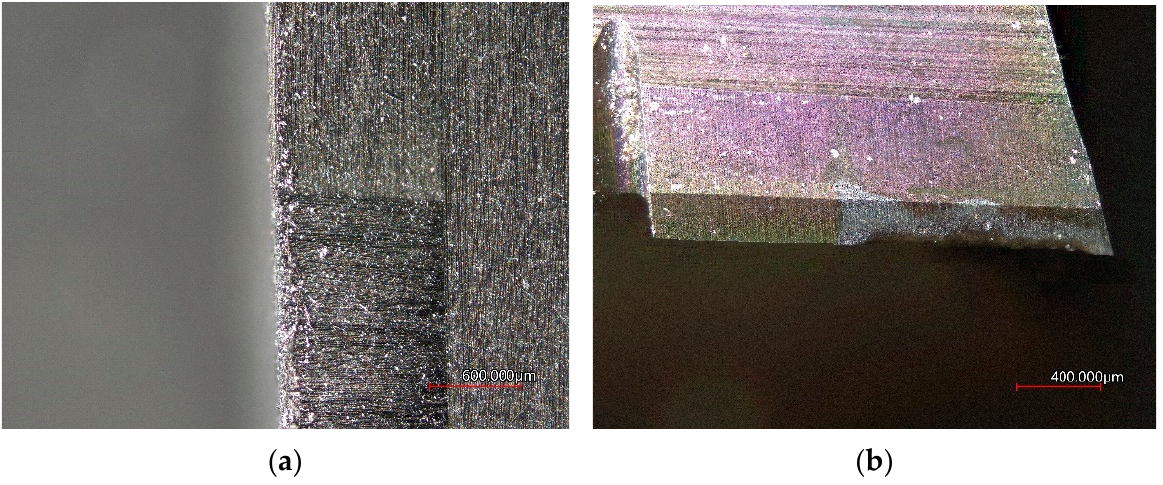
Figure 11. Capture after a tool tooth path of 15 × 165 m. ( a ) Laminate thickness 1 mm; ( b ) ECSSF milling tool.